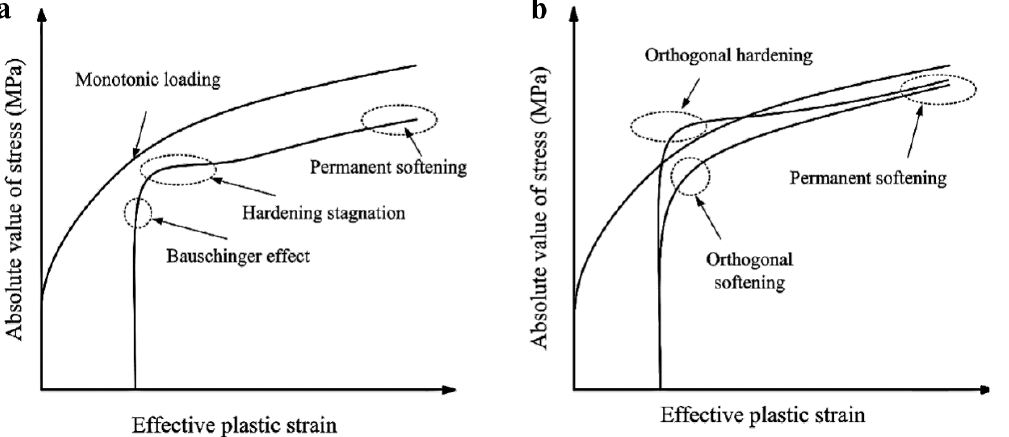
Figure 1. Schematic of the anisotropic hardening behaviors introduced by ( a ) reverse loading and ( b ) orthogonal loading. Reprinted with permission from Ref. [23]. 2018, Qin, J. et al.